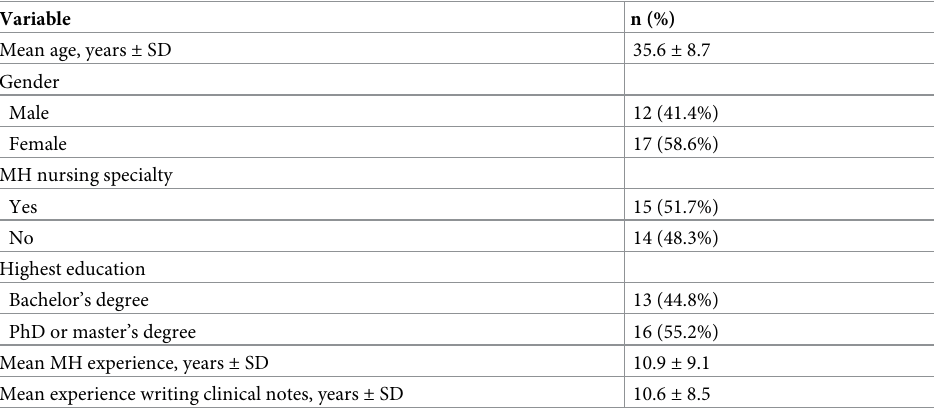
Fig 2. Structure of the original SESPI scale (Scale for the Evaluation of Staff Patient Interactions in Progress Notes) &SESPI-Sp]. https://doi.org/10.1371/journal.pone.0281832.g002 Table 1. Participants’ sociodemographic and professional characteristics (n =